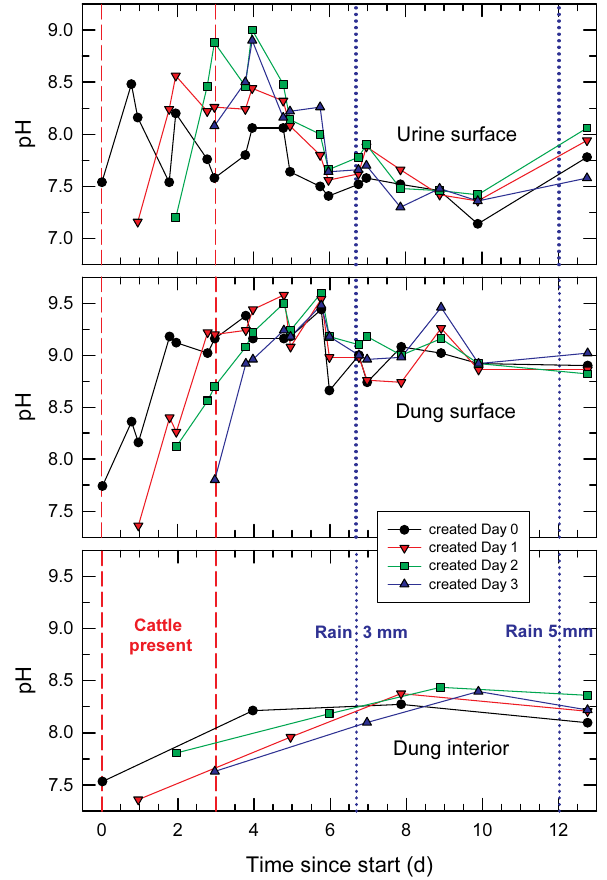
Fig. 3. Temporal evolution of pH on urine patch surfaces (top panel), dung pat surfaces (middle) and inside dung pats (bottom). The period of cattle presence is indicated by vertical dashed lines, and the two rain events with more than 1mm yield are marked by dotted